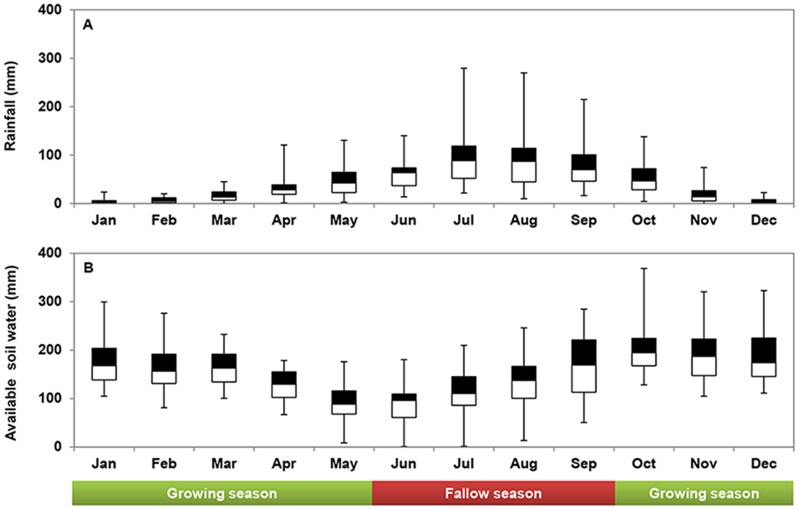
Monthly rainfall and available soil water during the period 1980–2010. A: monthly rainfall distribution; B: monthly available water content.Black and white boxes show 75 and 25% percentile values. Whiskers show maximum and minimum values (the same applies to other figures). The growing season of winter wheat was 245 days from 1 October to 1 June. of the next year, highlighted in green bar. Fallow season was 120 days from 2nd Jun. to 30th Sep., highlighted in red bar.